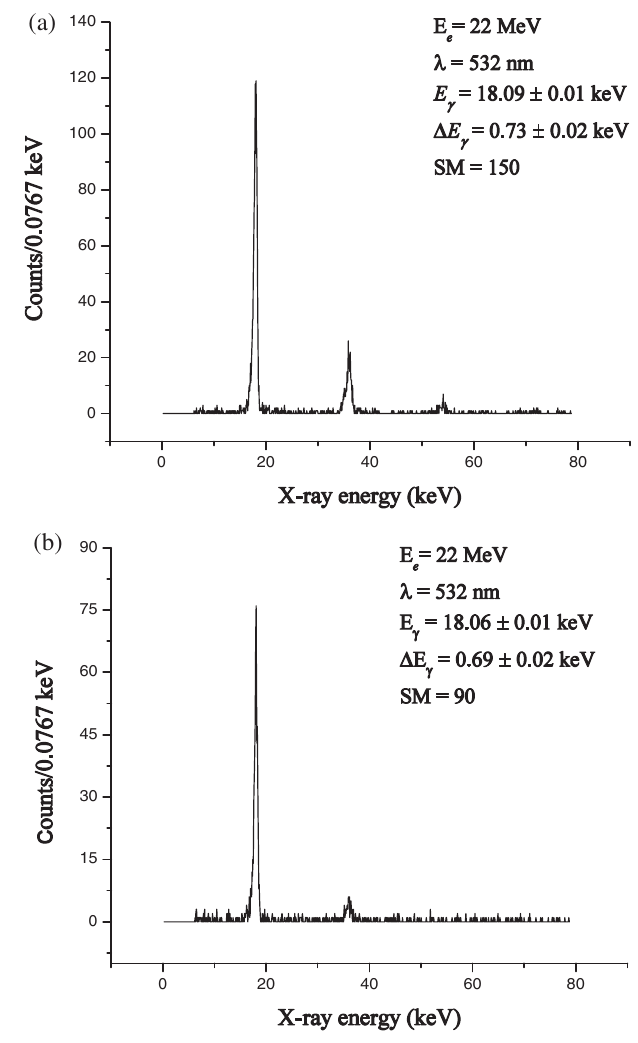
FIG. 7. (a),(b) LCS spectra for a SM readout equal to 150 and 90, respectively. The electron beam macropulse charges were equal to 0.5 and 0.2 nC. Only the first pileup peak is visible when SM (cid:2) 90 and the primary LCS peak FWHM is lower than the one at larger slit